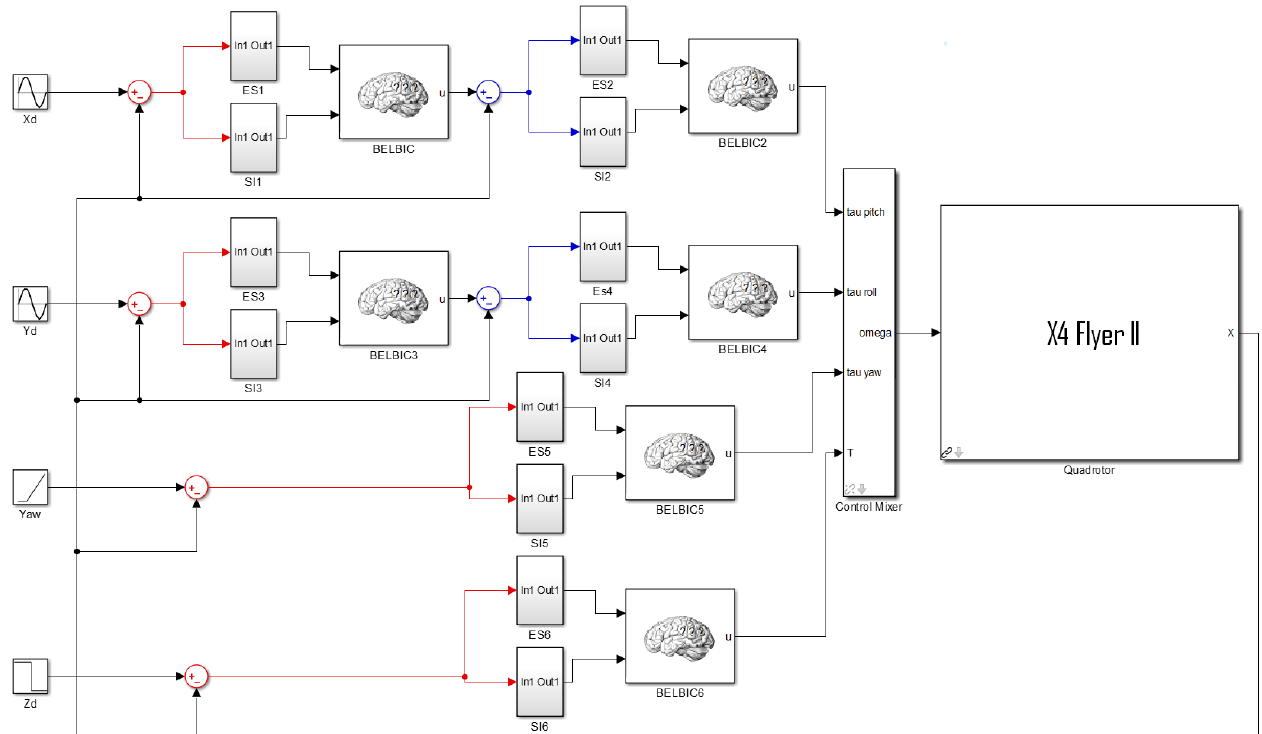
Figure 5. MATLAB-based block diagram of the UAV autonomous control system with BELBIC controllers (inputs: UAV’s desired position in x d , y d , and z d axis and desired yaw angle ψ d ; while output: UAV state vector of current position and